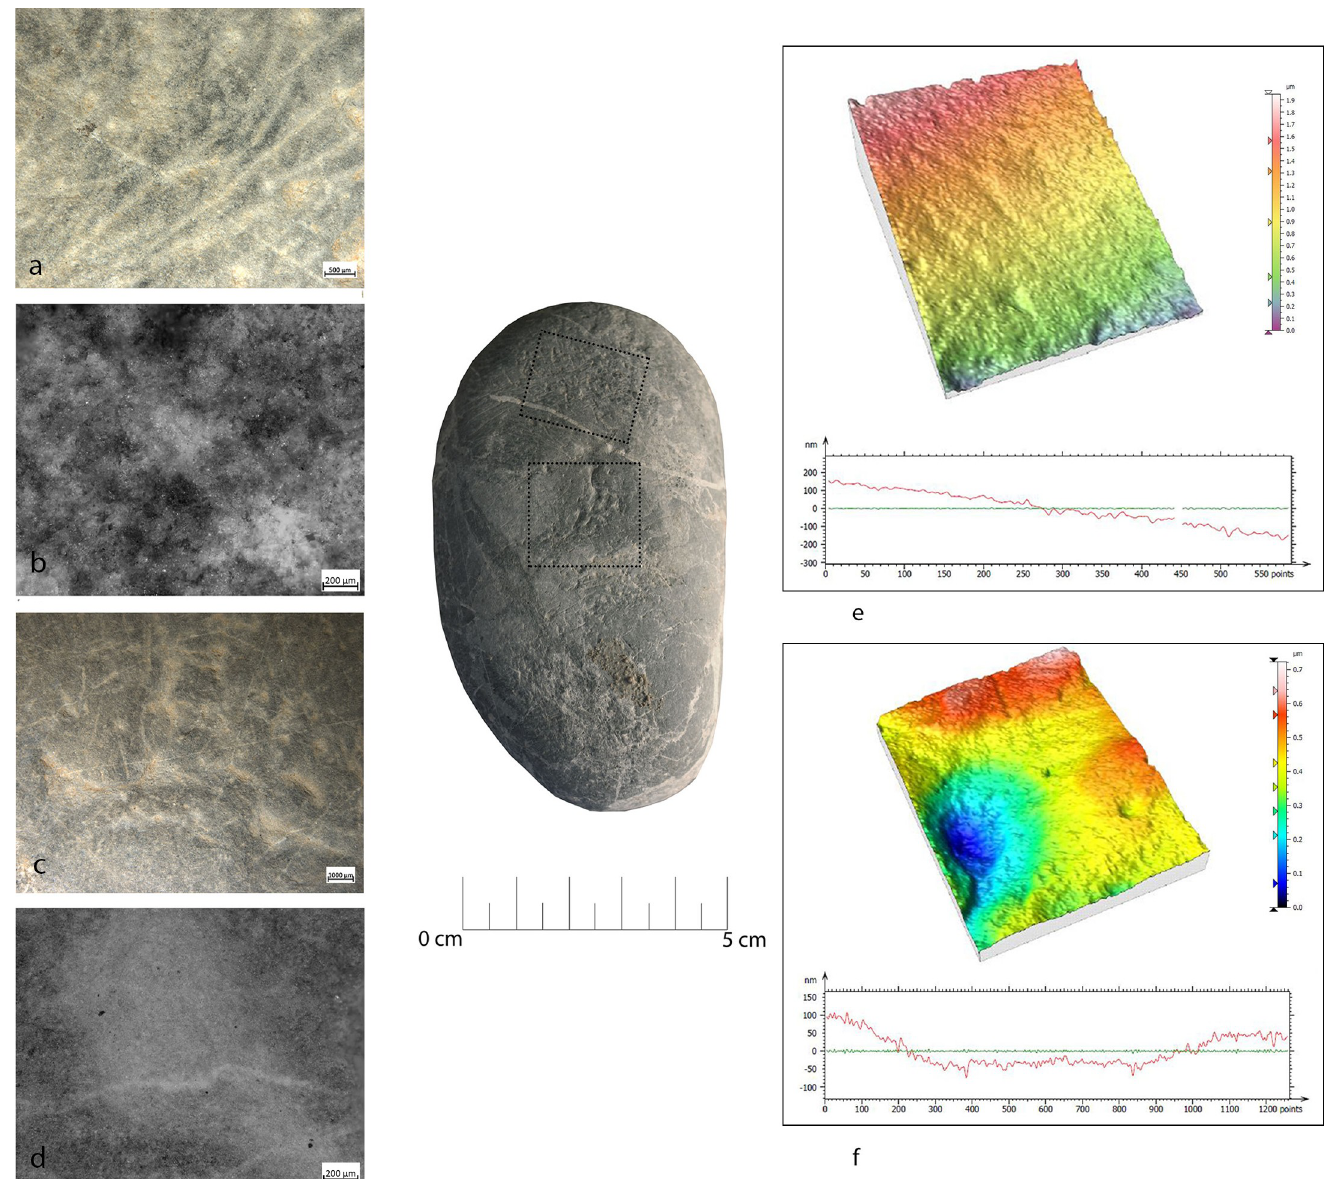
Fig 22. Use wear identified on artefact RF92. (a) Macro-traces (20x), micro-pits with sub-circular morphology associated with long parallel striations, located in the apical top with oblique orientation; (b) micro-traces (200x) are absent, a general rounding is visible; (c) macro-traces (20x), pits with triangular morphology, located in the centre area of the flat surface; (d) polishing is absent (200x); (e) 3D microtopography and profile of the used surface related to (a-b); (f) microtopography and profile of the used surface related to